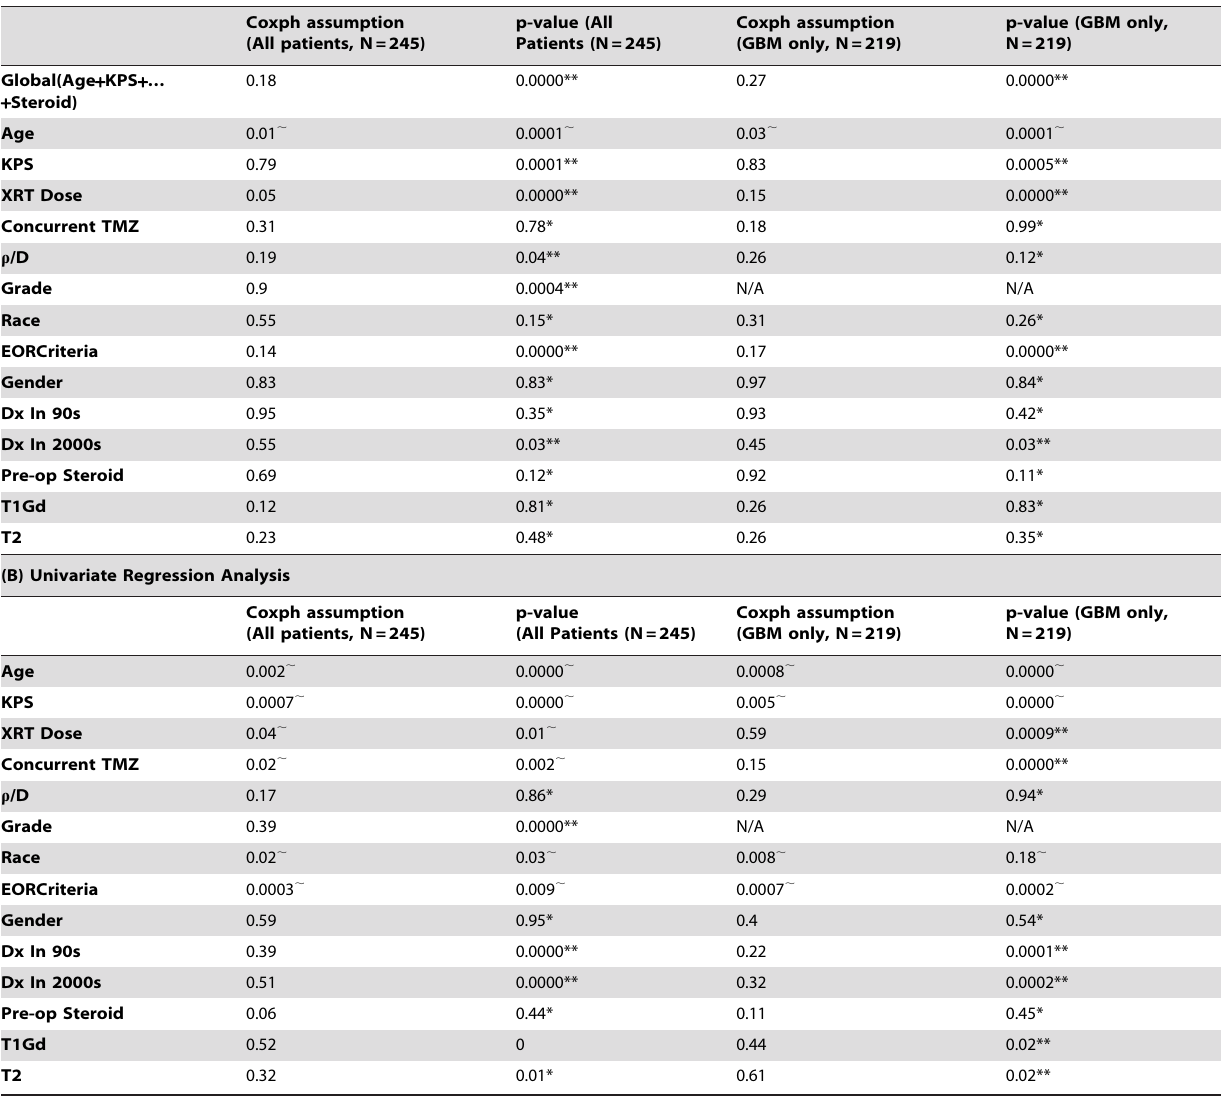
(A) Multivariate Regression Analysis